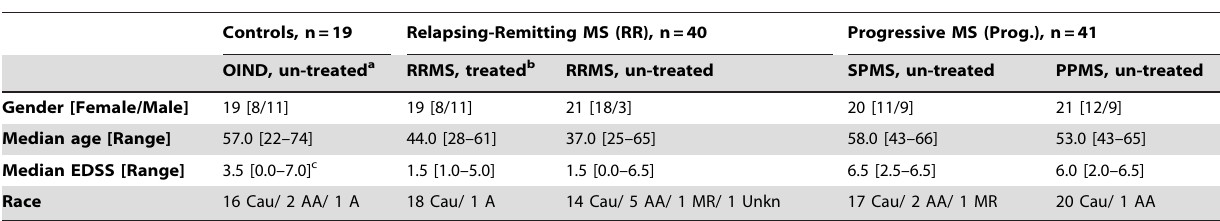
Table 1. Patients’ demographics and clinical characteristics.